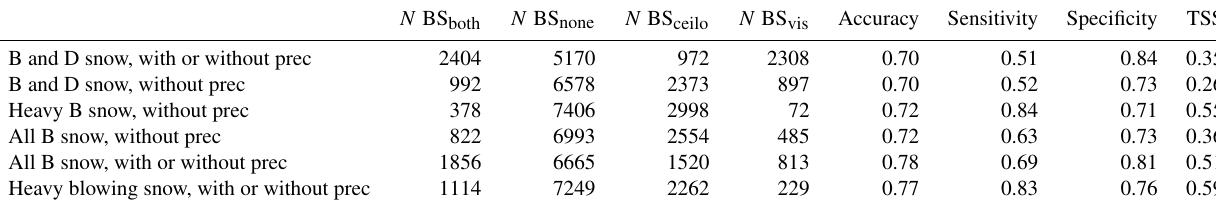
Table 3. Detection numbers and scores of the different categories of observations. The first four columns give the numbers for all four categories: N BS both stands for blowing snow detected by both the algorithm and the visual observations; N BS none indicates both methods agree that there is no blowing snow; N BS ceilo and N BS vis represent detections by the algorithm and the observer only, respectively (the corresponding percentages are presented in Table S4). The four last columns give the scores; TSS is true skill statistics. B stands for blowing and D for drifting snow; prec is precipitation. The total number of measurements is 10584. N BS both N BS none N BS